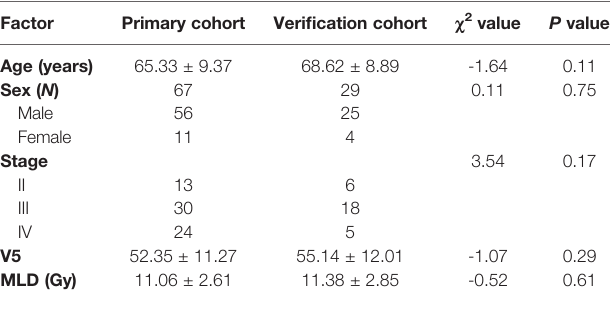
TABLE 3 | Comparison of sex, age, tumor stage, V5, and MLD between the primary and the veri fi cation